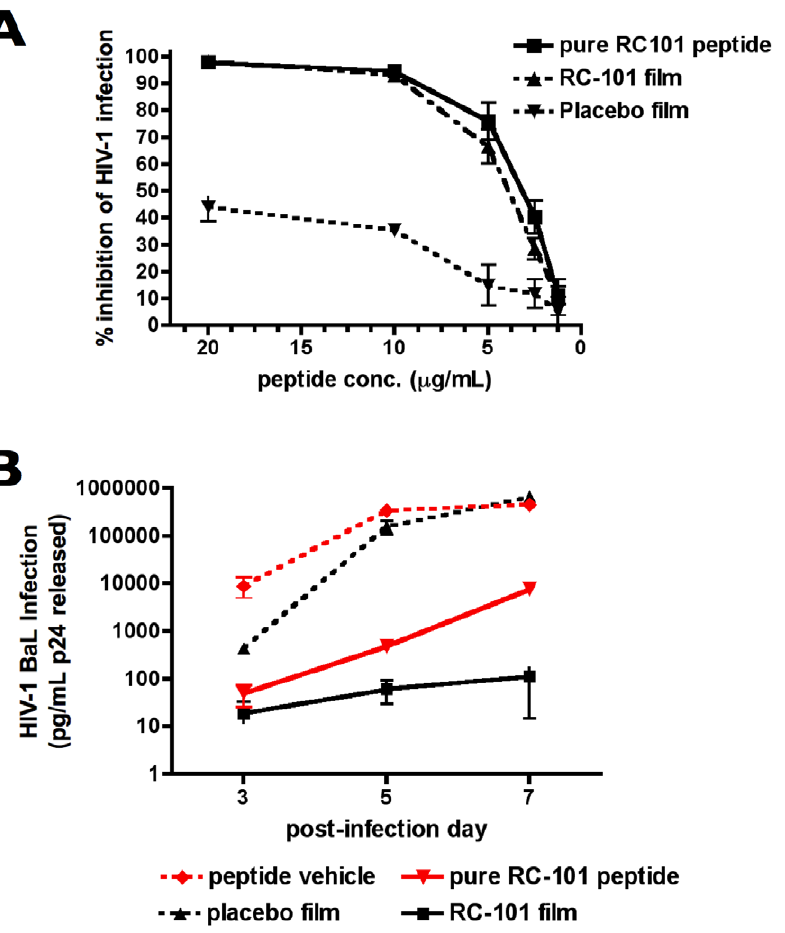
Figure 1. Activity of formulated RC-101 is equivalent to unformulated peptide. Antiviral activities of RC-101-containing films and placebo films against HIV-1 strain BaL were compared against unformulated ‘‘pure’’ RC-101 peptide in TZM-bl reporter assays expressed as percent inhibition of HIV-1 infection ( A ) and p24 gag release assay in PM1 cells expressed in pg/ml of p24 released ( B ). p24 gag differed between formulated and unformulated RC-101 at days 5 and 7, P , 0.001 and P =0.019, respectively. Error bars represent SEM; n=2-5.